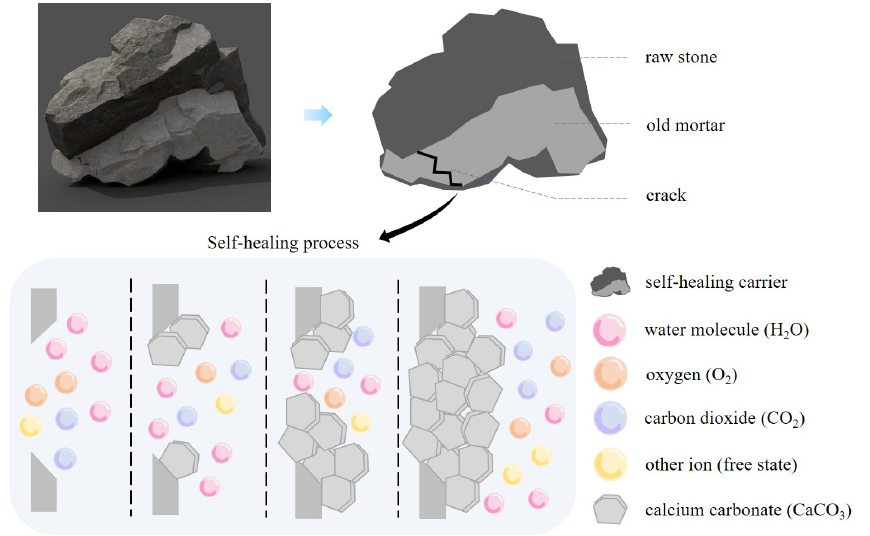
Figure 5. Schematic representation of the activation of self-healing to crack repair.